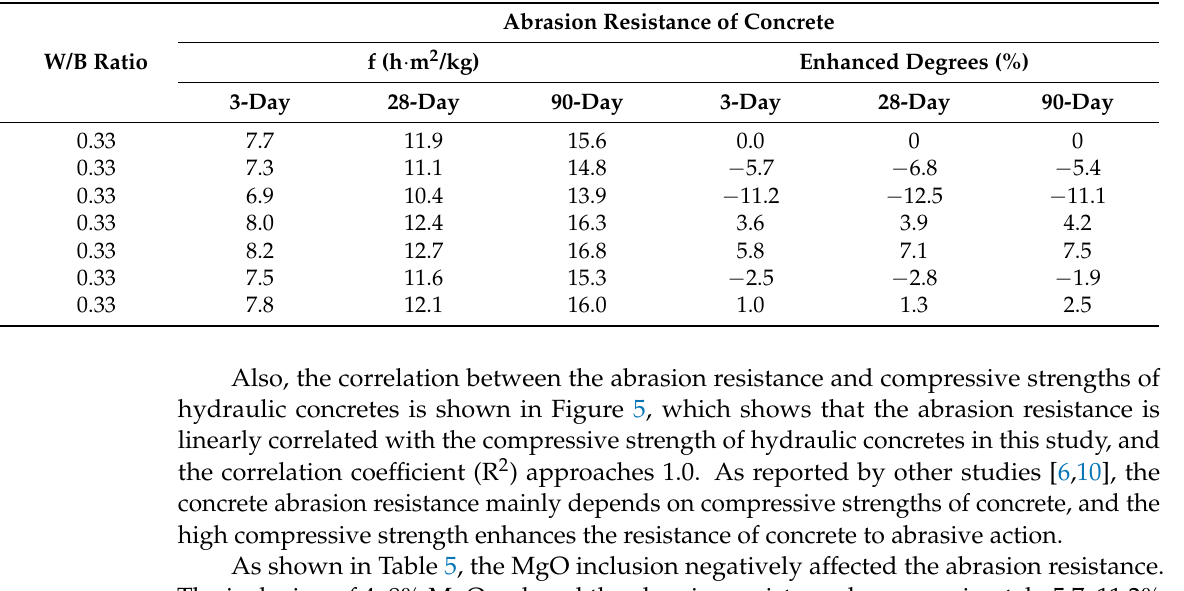
Table 5. The abrasion resistance of hydraulic concretes added with MgO and/or PVA